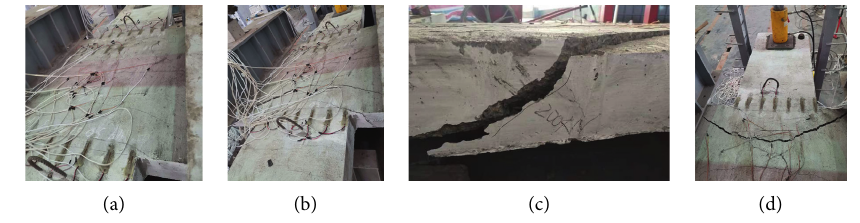
Figure 7: Destruction process and failure pattern of Specimen